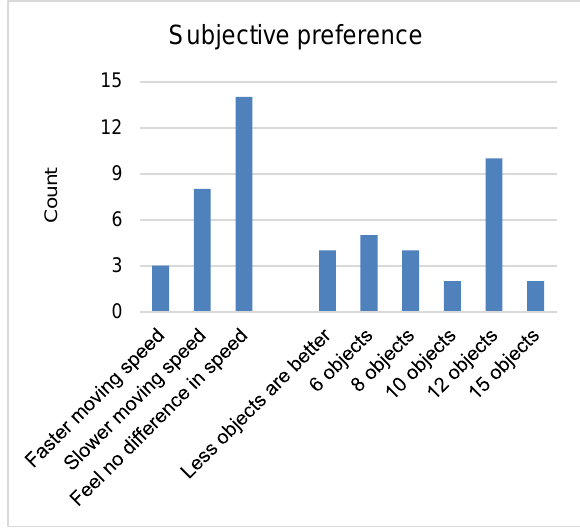
Figure 10: Subjective feedback from participants. The interface with 12 moving objects was preferred by 10 participants. Open answers to their reasoning